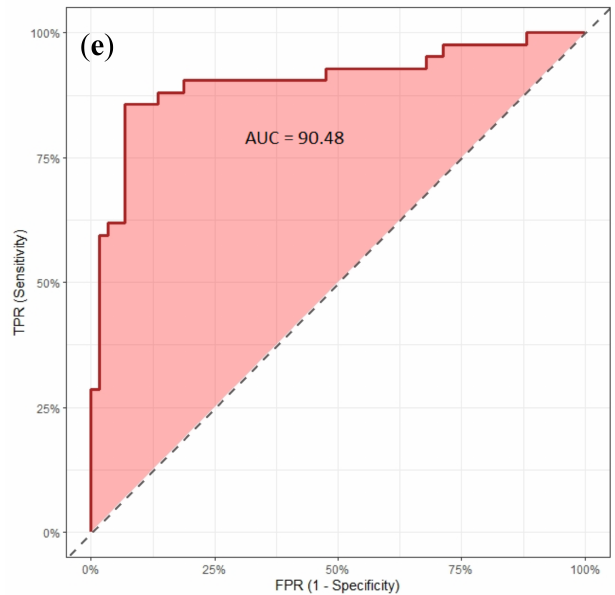
Figure 7. Evaluation models in the testing stage for mapping groundwater potential based on AUC: